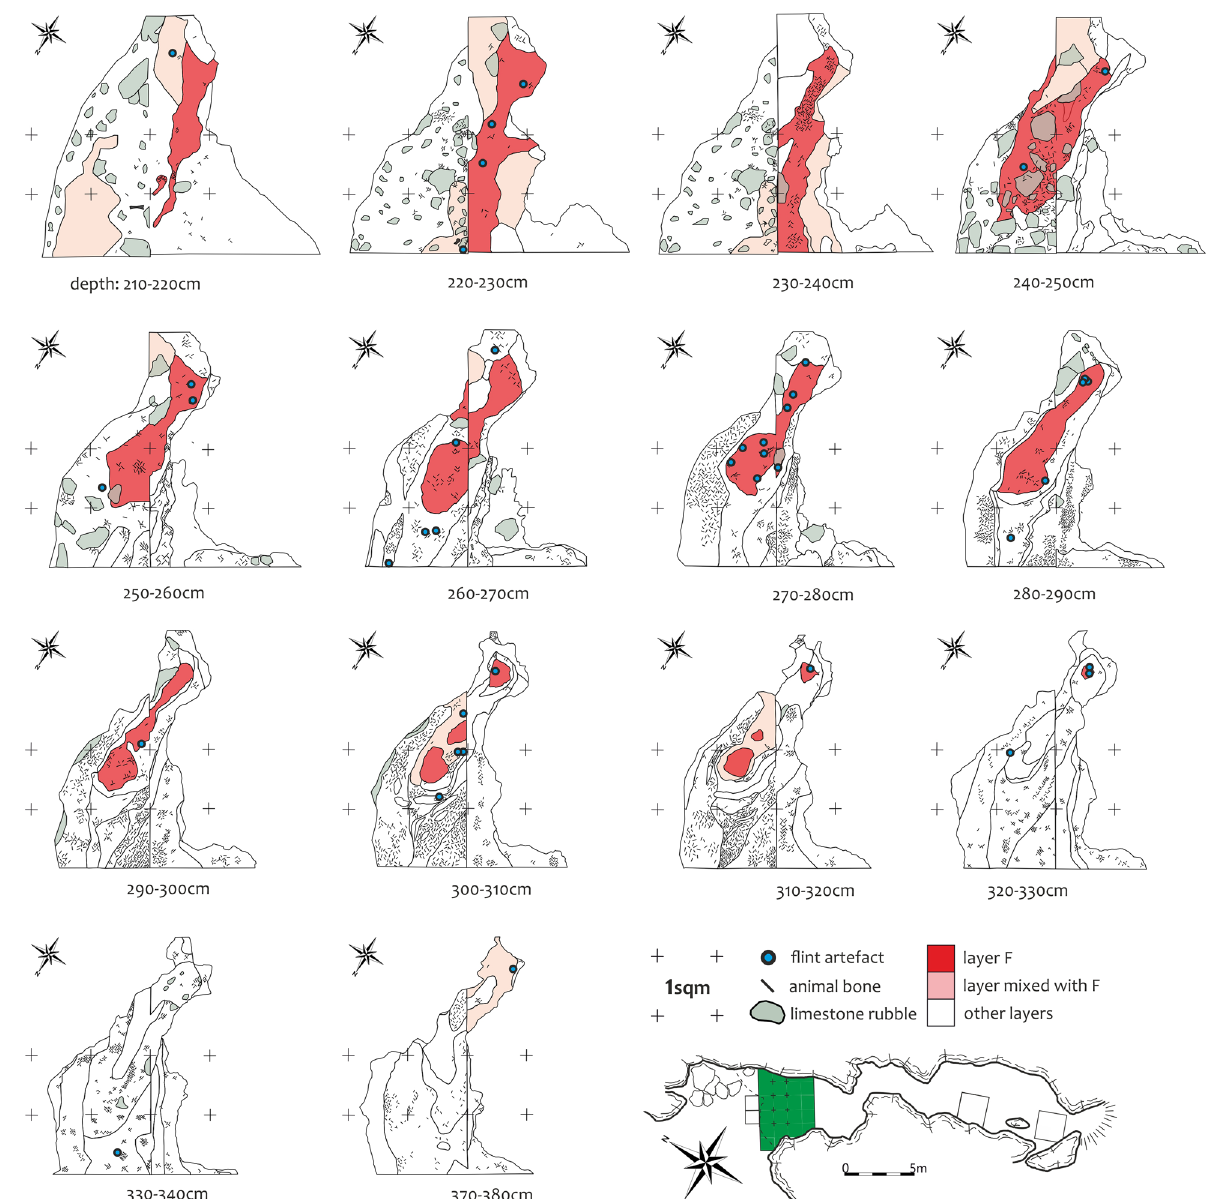
Figure 4. Tunel Wielki Cave. Planigraphy of stone artefacts at different depths under the surface. Layer F is the uppermost one of the whole package of Pleistocene loams. It was preserved in the form of an inclined lens surrounded by the underlying strata, which were found in the form of circles around layer F. The stratigraphic position of the layer and the artefacts was caused by creeping processes leading to the slow movement of the whole loam package toward the vertical chimney in the bottom of the